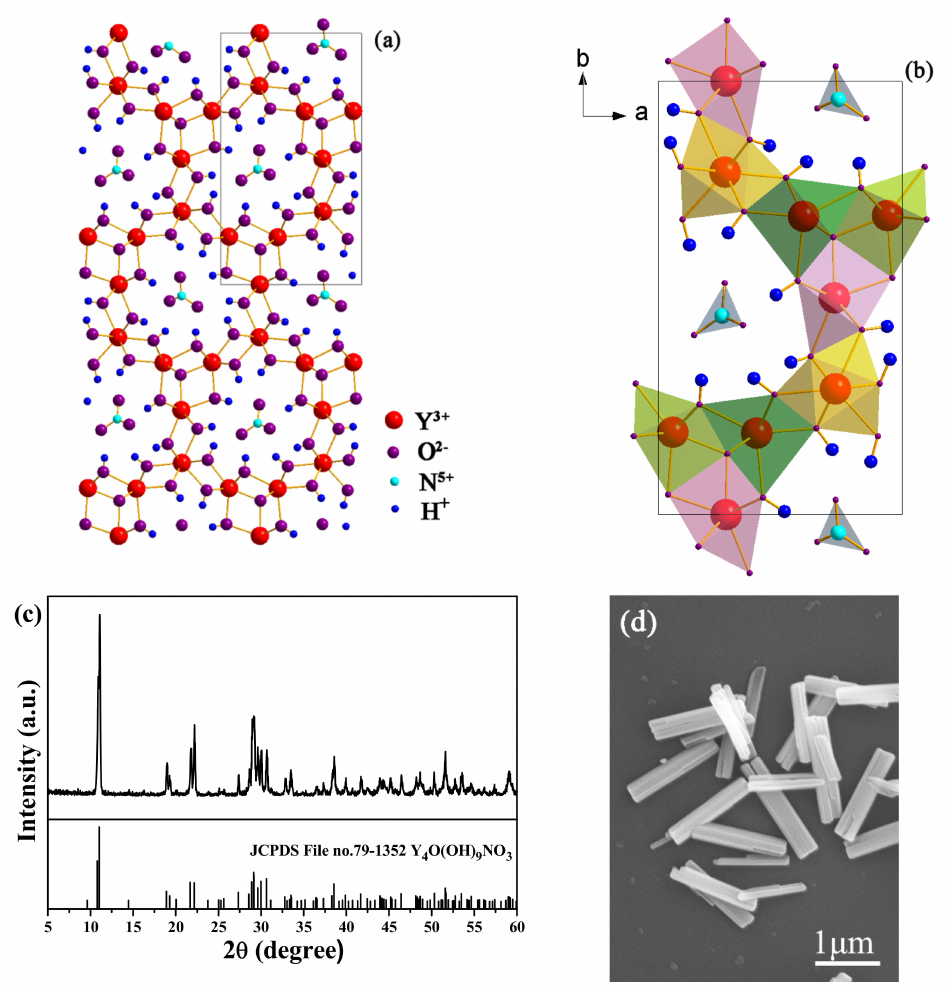
Figure 1. ( a , b ) Crystal structure of Y 4 O(OH) 9 NO 3 , ( c ) XRD patterns, and ( d ) FE-SEM image of